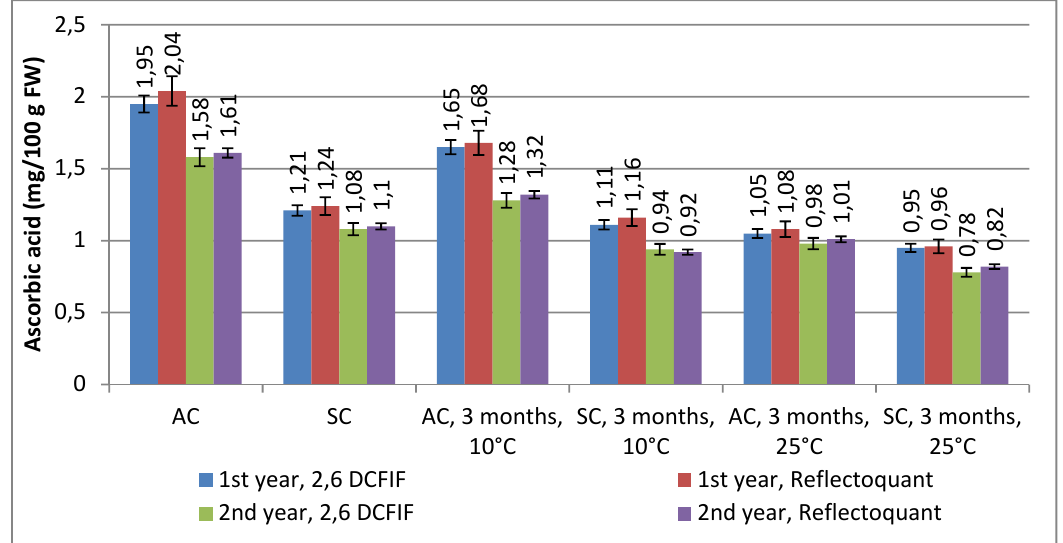
Figure 3. Ascorbic acid content after 3 months of preservation at 10 °C and 25 °C: apricots from compote (AC), syrup from compote (SC), during two different years and employing 2,6 dichlorophenol indophenol and Reflectoquant methods. Results are means of 3 determinations±standard